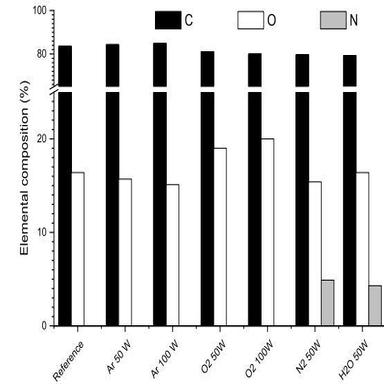
Elemental composition of the untreated and plasma-treated CF for different gasses and applied powers with a fixed exposure time (5 min).